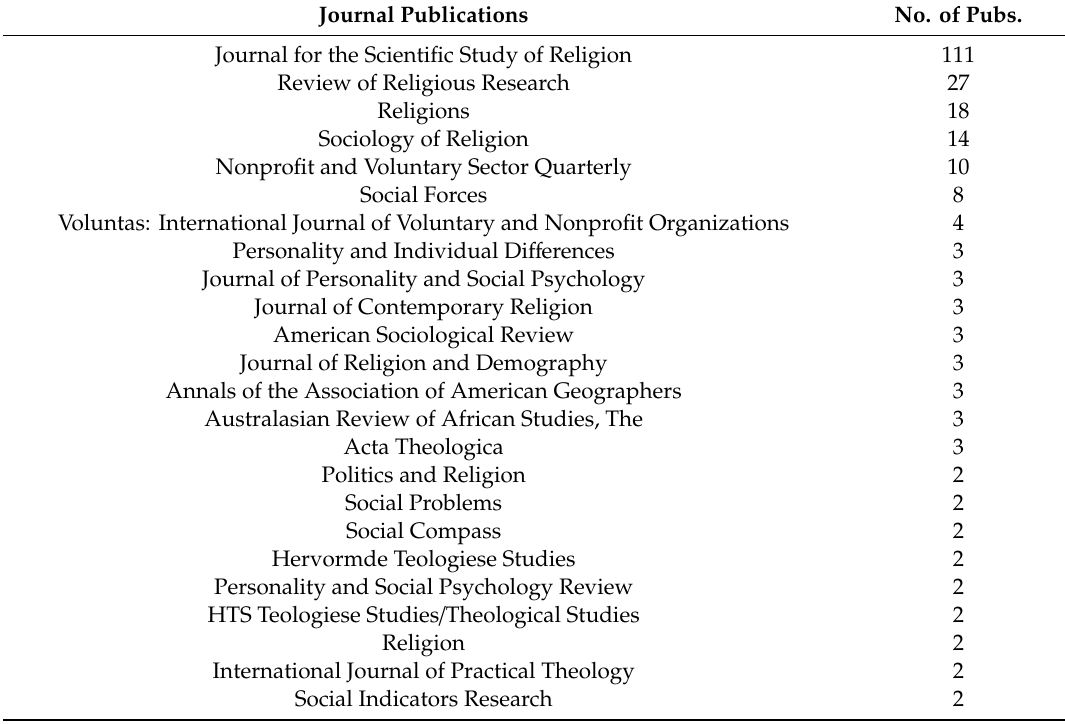
Figure 2. Publication frequencies by year of publication. Source : Author compilation. Table 1. Selection of primary journal outlets by publication